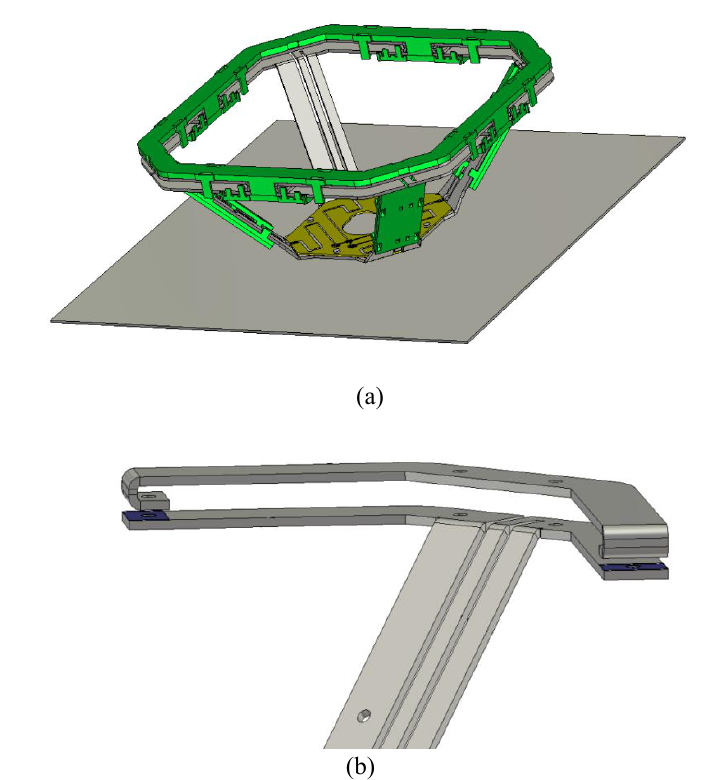
Fig. 2 . Appearance of the square dipole (a) perspective view, (b) placed of additional conductivity members of the